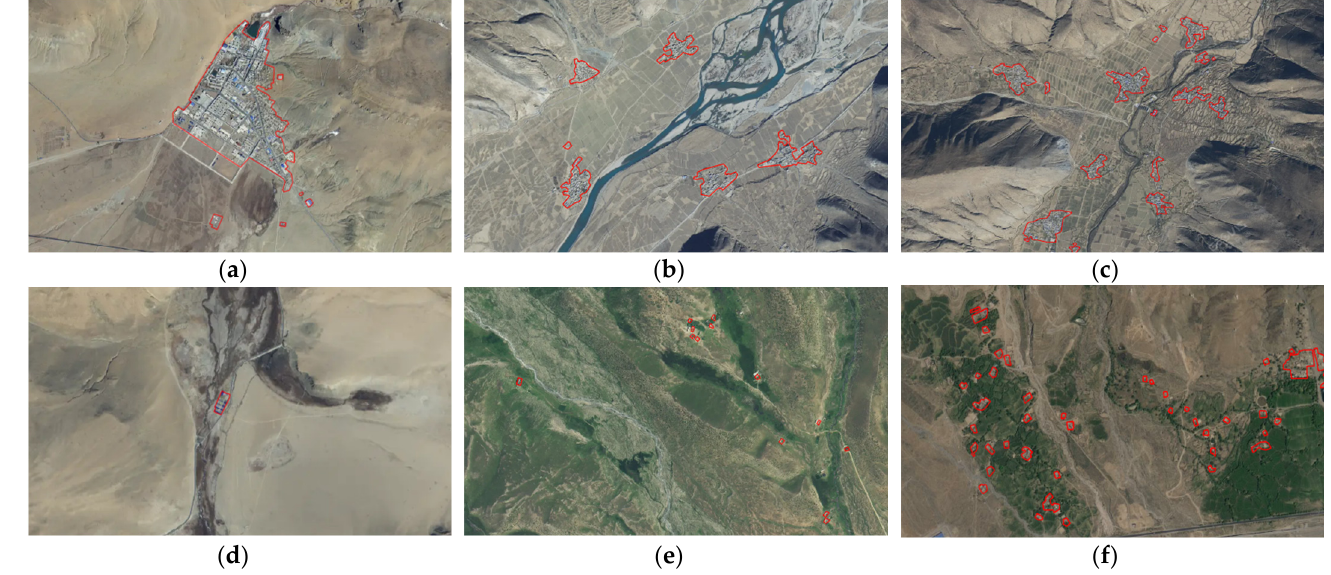
Figure 3. Satellite maps of typical residential areas: ( a ) Large-patch dominant type; ( b ) Low-density and cluster type; ( c ) Medium-density and cluster type; ( d ) Small-patch isolated type; ( e ) Low-density and scattered-point type; ( f ) High-density and scattered-point type.